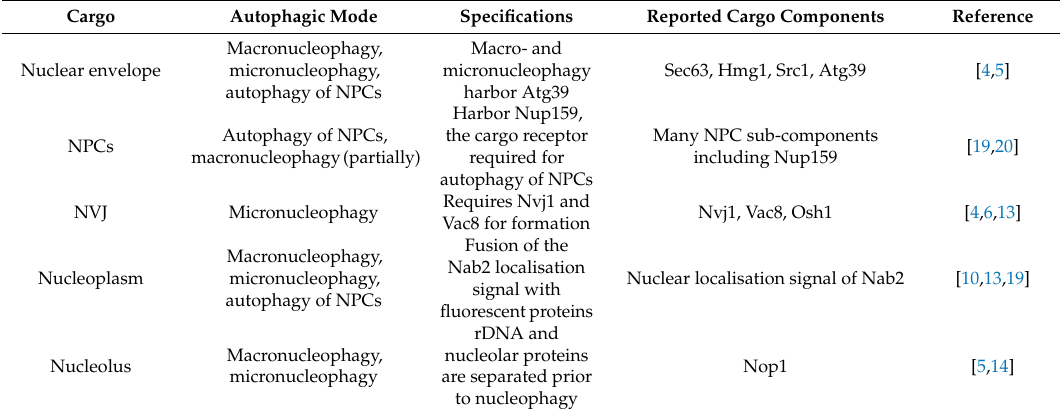
Table 1. Known nuclear cargos and their associated autophagic modes described in S. cerevisiae